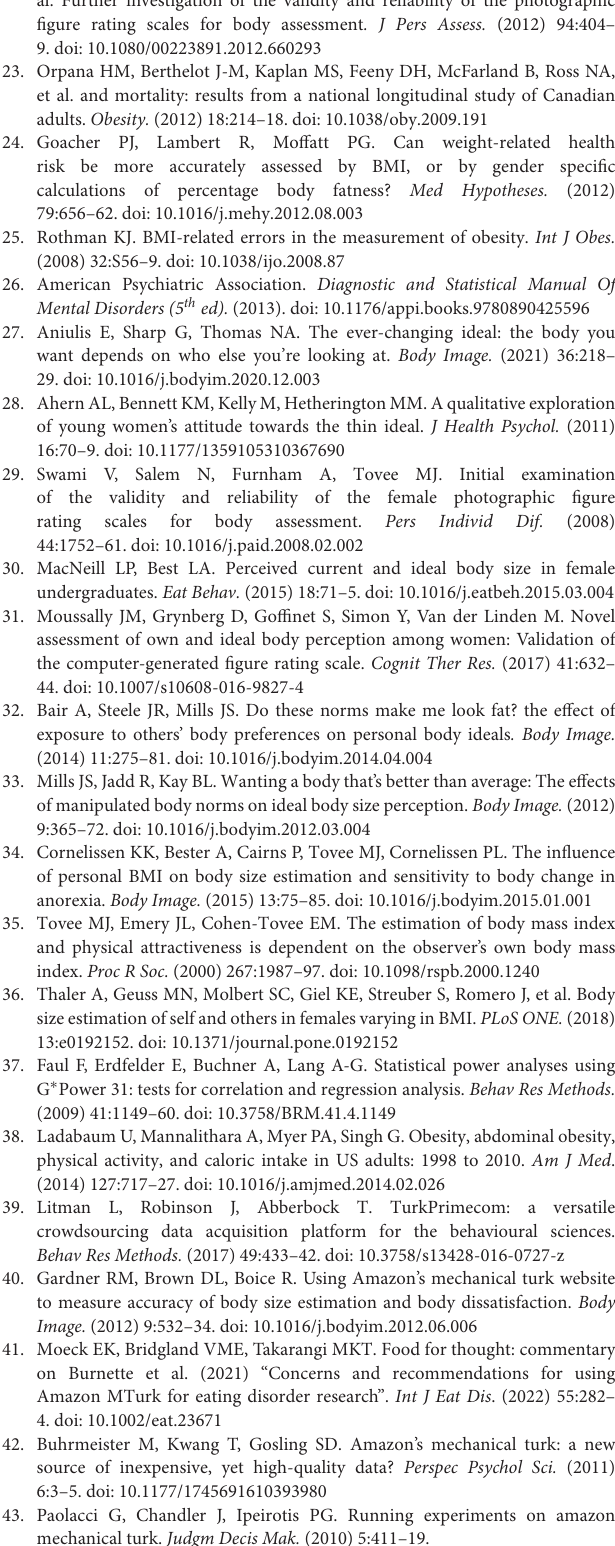
figure rating scales for body assessment . J Pers Assess. (2012) 94:404– 9. doi: